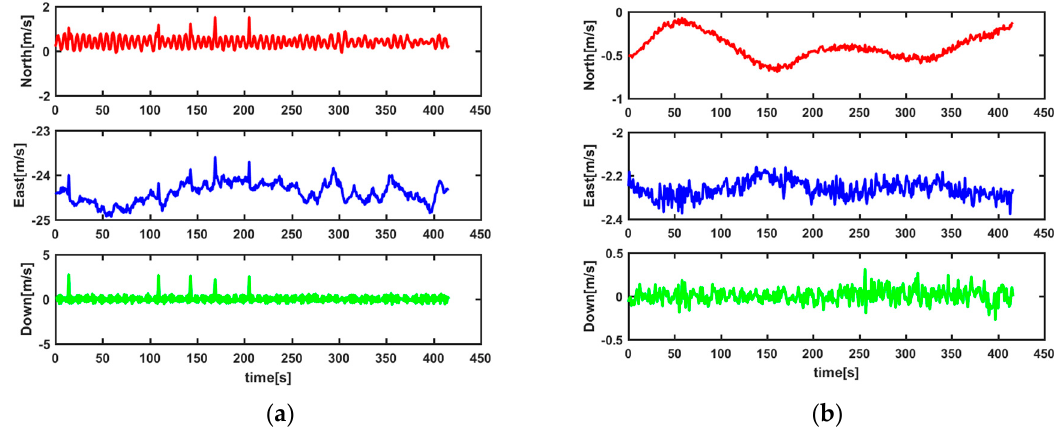
Figure 12. Velocities (NED) of the UAV and boat in test 2. ( a ) UAV; ( b ) boat.